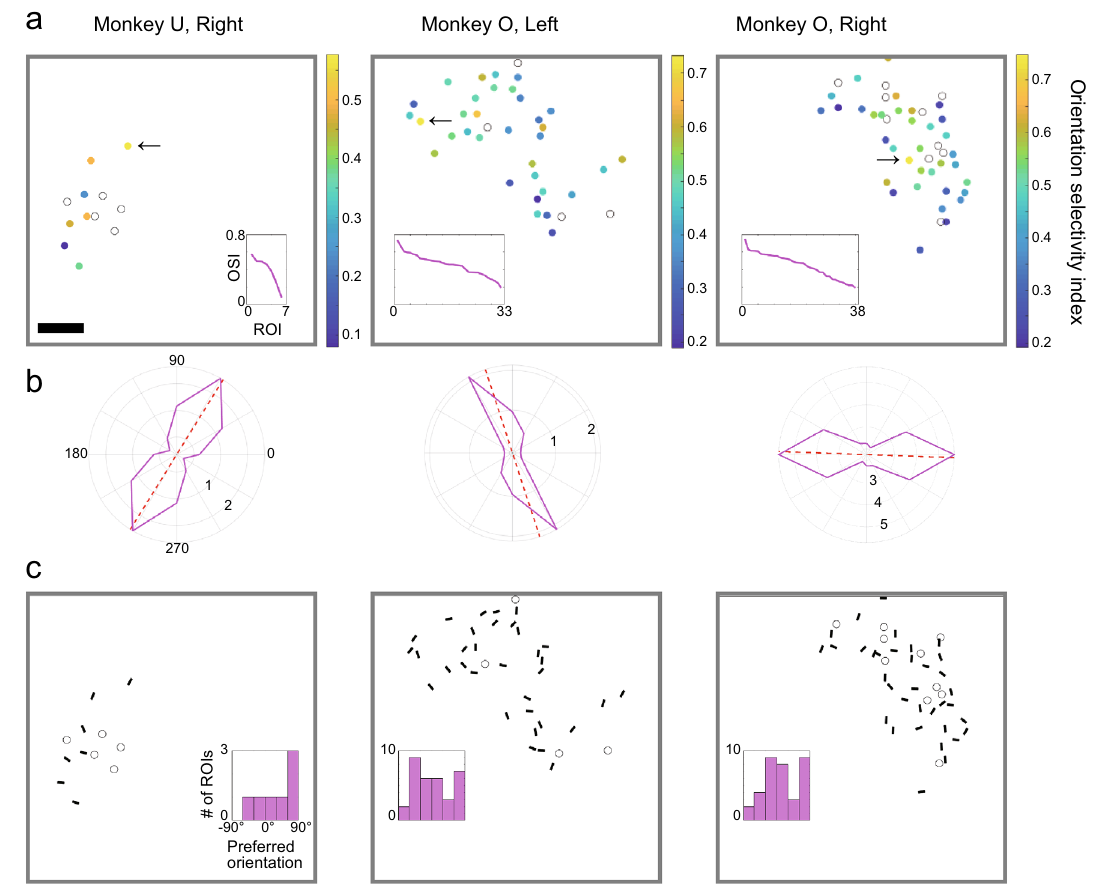
Figure 6. Maps of orientation selectivity and preferred orientation. ( a ) Color maps of OSI values of detected ROIs. The recording sessions used are the same with those used in Fig. 5. Filled circles indicate ROIs with stimulus responses, and open circles indicate ROIs without stimulus responses. The color of each filled circle represents the OSI value shown in the color bar. Inset: A graph showing the OSI values from largest to smallest in the corresponding map. Scale bar: 100 µm. ( b ) Polar coordinate displays of signal intensity for each orientation calculated from the time-series data of the ROI indicated by the black arrows in ( a ). Radial distance means normalized signal strength (ΔF/F0). The dashed red line represents the preferred orientation of this putative neuron. ( c ) The orientation of each black bar represents the preferred orientation of the corresponding ROI with stimulus responses. Open circles indicate ROIs without stimulus responses. Inset: A histogram showing the distribution of preferred orientation in the corresponding